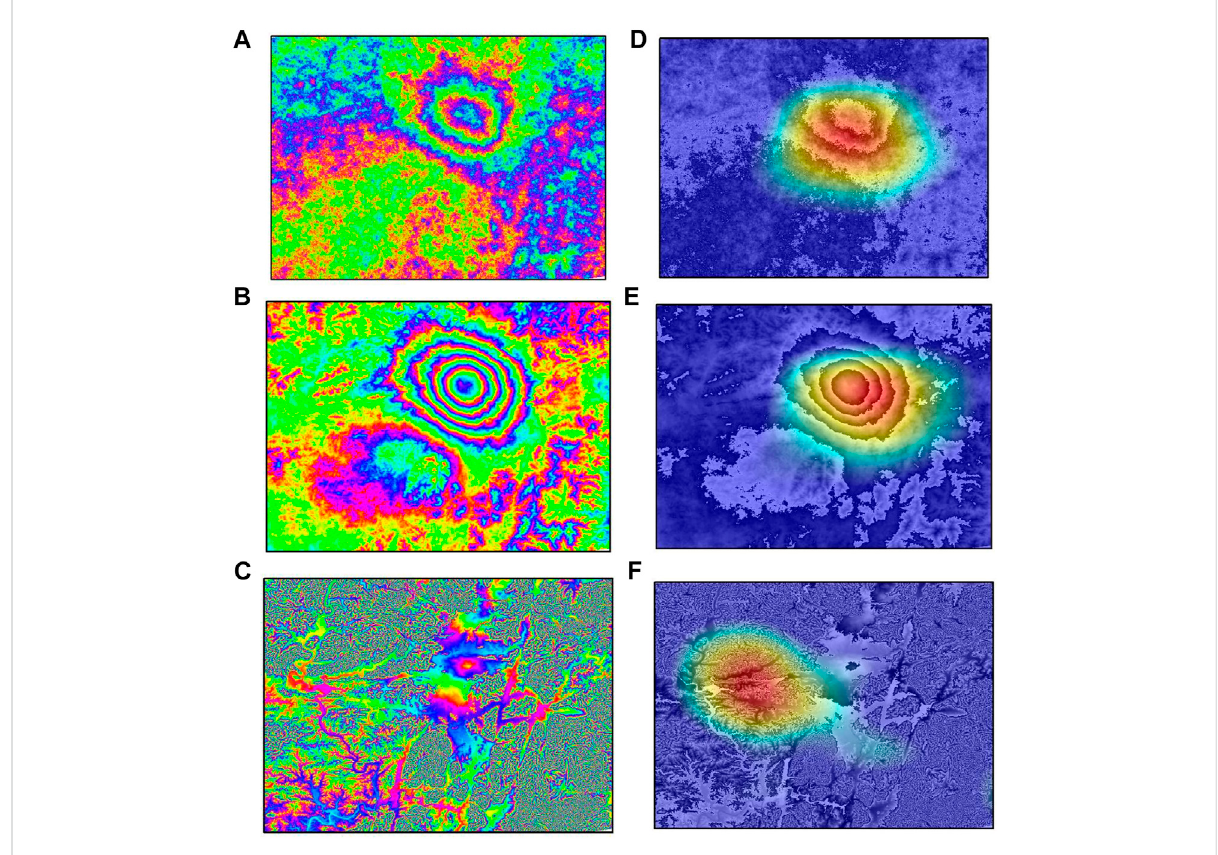
Input image from training dataset (A) synthesis deformation label, (B) synthesis deformation label, (C) atmospheric label and overlaid CAM analysis of image (D) deformation label with a probability of 98%, (E) deformation label with a probability of 91.2%, and (F) atmospheric label image with a probability 90.7%. The red area of the CAM represents a high probability of classi fi cation